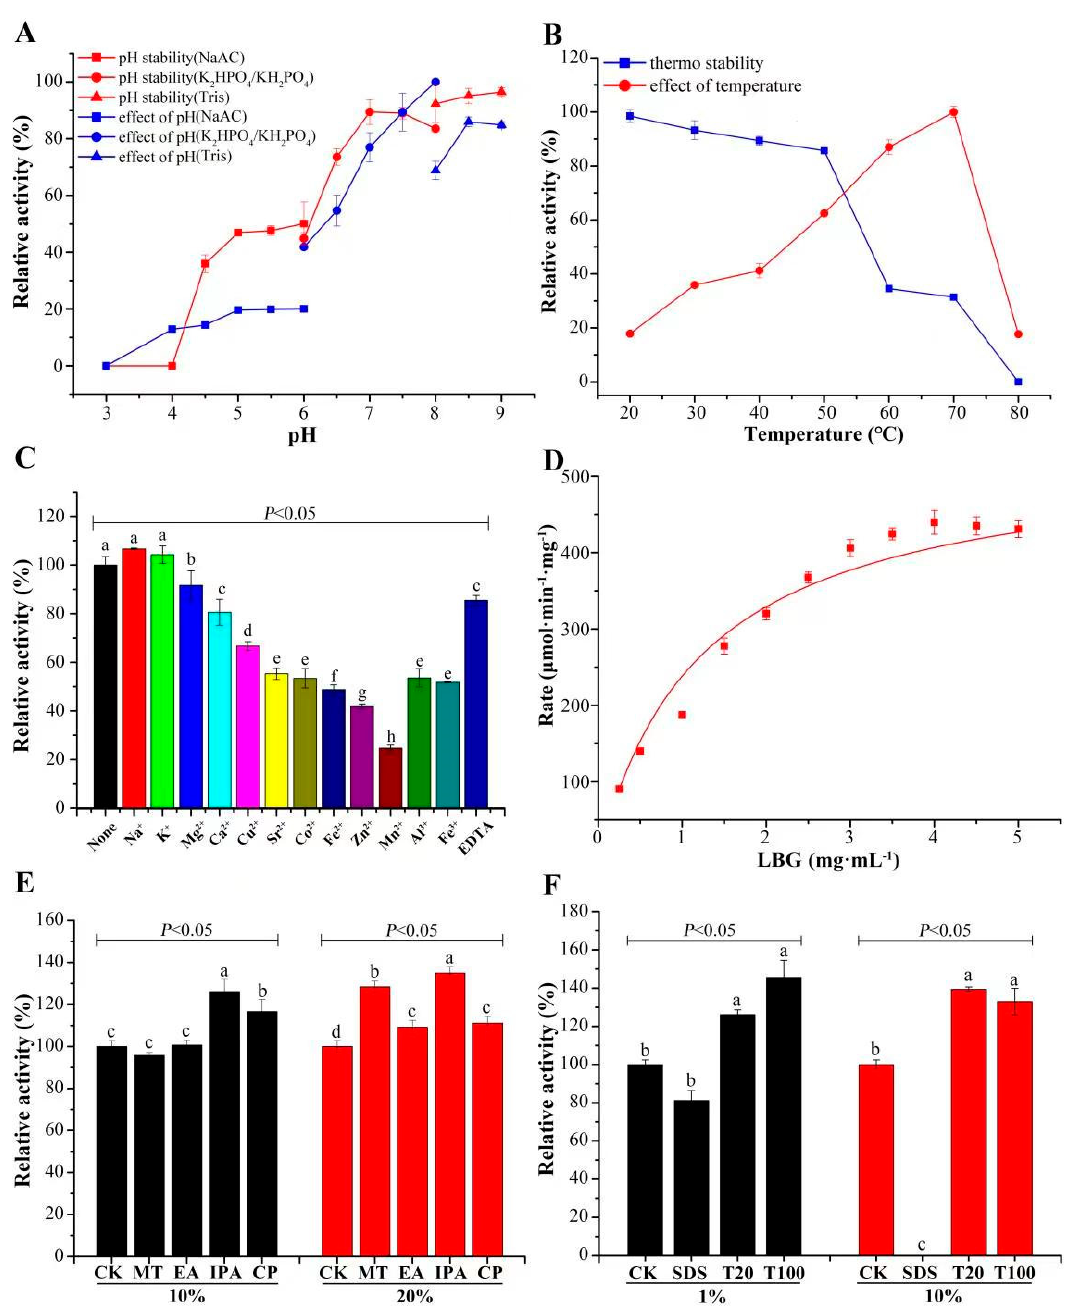
Figure 2. Enzyme features of CcMan5C under assay conditions. ( A ) The pH effect and pH stability of CcMan5C hydrolytic activity toward LBG at 50 ◦ C. ( B ) The temperature effect and thermostability of CcMan5C hydrolytic activity toward LBG at pH 8.0. ( C ) Effects of metal ions and EDTA at 1 mM on CcMan5C hydrolytic activity. ( D ) The effect of LBG concentration on CcMan5C hydrolytic activity. ( E ) Effects of some organic solvents on CcMan5C hydrolytic activity. CK, control; MT, methyl alcohol; EA, ethyl alcohol; IPA, isopropyl alcohol; CP, acetone. ( F ) Effects of some deter- gents on CcMan5C activity toward LBG. CK, control; SDS, sodium dodecyl sulfate; T20, Tween 20; T100, Triton X-100. Data are means ± SDs ( n = 3). The data were statistically analyzed by Duncan’s test ( p < 0.05). The same letters indicate no significant difference ( p > 0.05) and different letters in- dicate significant differences ( p < 0.05) between hydrolytic activities of CcMan5C by Duncan’s test.